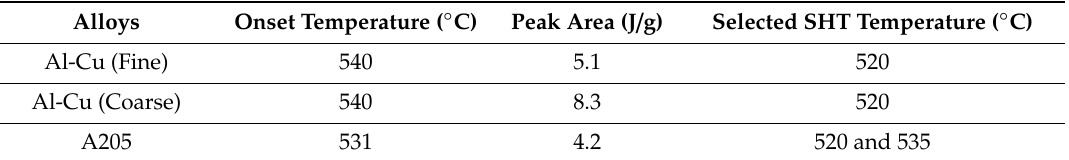
Table 2. The average onset temperatures, endothermic peak areas corresponding to Al 2 Cu melting derived from the DSC heating curves, and solution heat treatment (SHT)